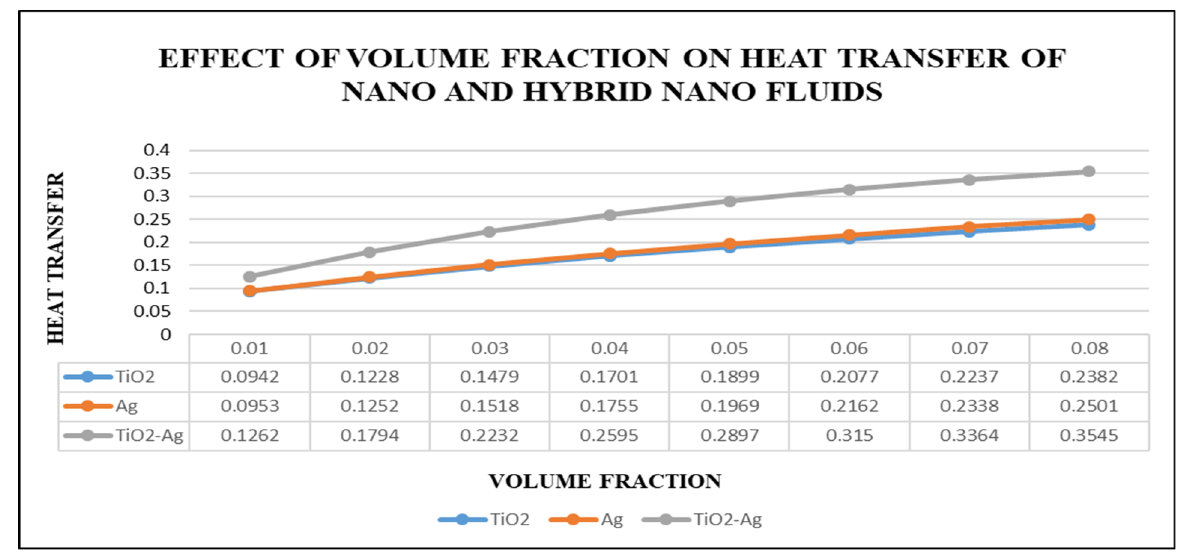
Figure 3. Results of T.C. on thickness ( a ) and radius ( b ).